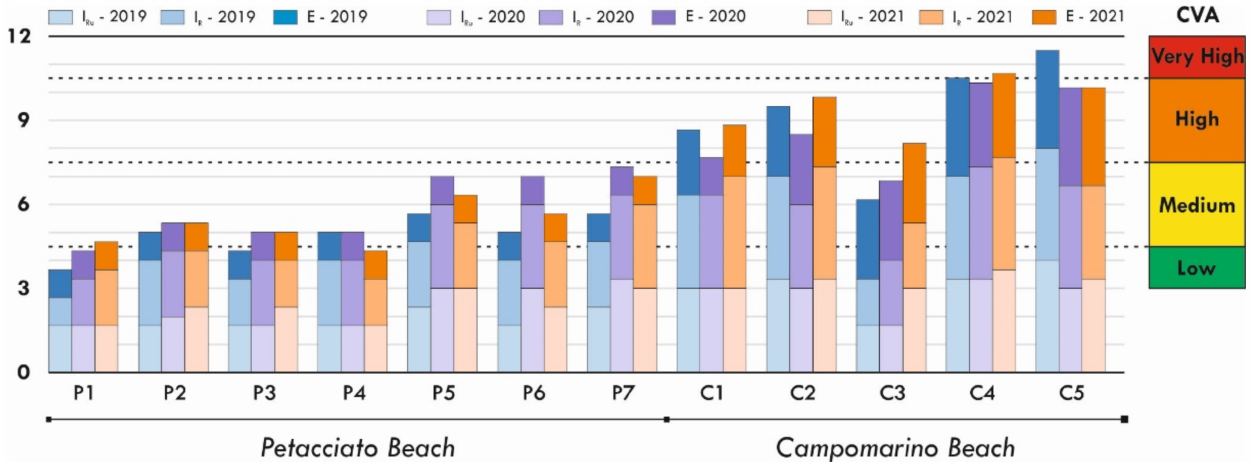
Figure 11. Comparison of I RU , I R , and E indexes and related CVA levels obtained respectively for 2019, 2020, and 2021 for the beach profiles surveyed in test areas A and B (Petacciato and Campomarino